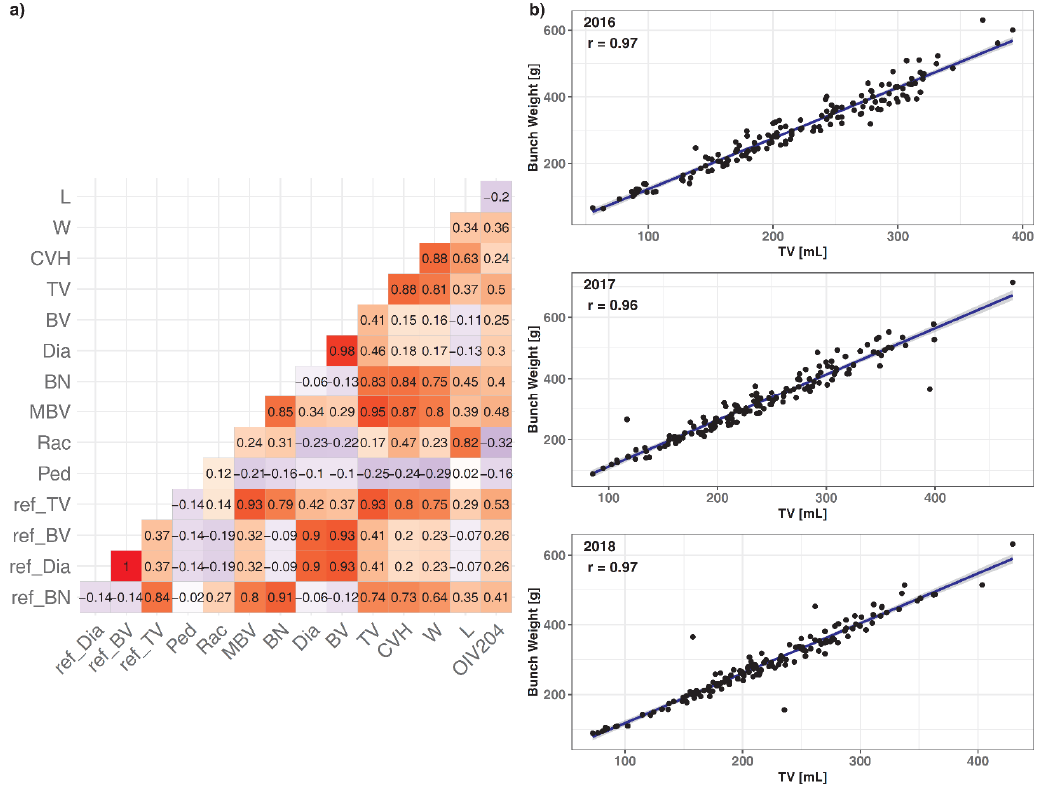
Figure 1. Assessment of 3D sensor data. Correlation plot of phenotypic 3D data (bunch length = L, bunch width = W, convex hull volume = CVH, total volume = TV, berry volume = BV, berry diameter = Dia, and berry number = BN). Reference measurements: manual measured bunch volume (MBV), 2D image data, (rachis length = Rac, pedicel length = Ped, total volume = ref_TV, berry volume = ref_BV, berry diameter = ref_Dia, and berry number = ref_BN), and OIV 204. The correlation coefficients are given for phenotypic measurements (3D, 2D, and manual) and OIV204 ratings from all individuals of the population C × V_150 ( n = 150) ( a ). Results of correlation between 3D total volume (TV) and Bunch Weight for the seasons 2016-2018 ( b ). Table 1. Detected QTLs from 3D and 2D reference phenotypic data of the population C × V _150. Shown are the LODmax positions, LODmax values, and the explained phenotypic variance for the detected QTLs of the respective phenotypic traits measured in the season 2016. BN = berry number, L = bunch length/rachis length, Dia = berry diameter, BV = berry volume, and TV = total volume. 3D